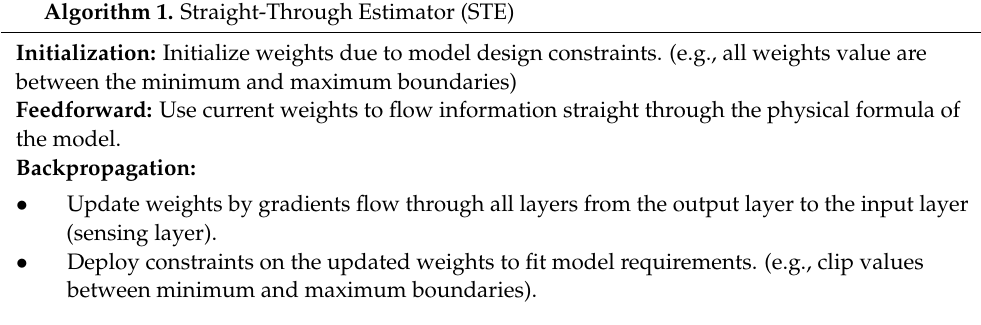
Figure 3 and Algorithm 1 depict the STE mechanism: Algorithm 1. Straight-Through Estimator (STE)